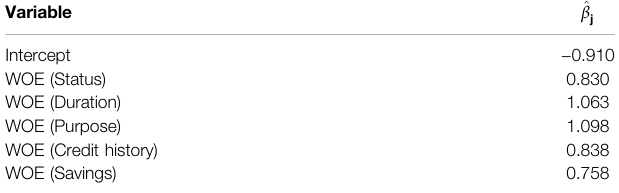
TABLE 5 | Coef fi cients of the logistic regression model. Variable ^ β j Intercept −